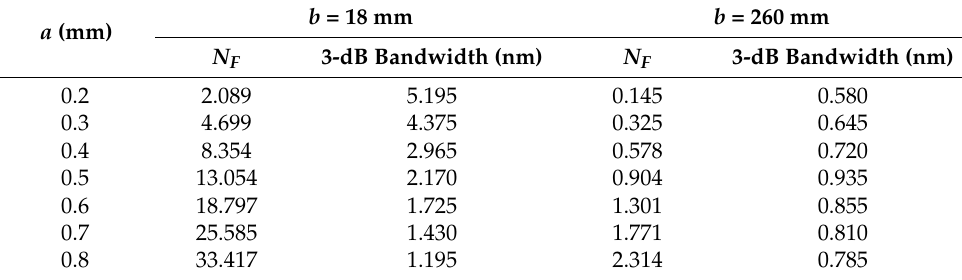
Figure 5. Bandwidth variation as function of the slit widths for b values of 18 mm and 260 mm and as function of the gratings length, L (for λ = 1532 nm and n eff = 1.445). Table 1. N F and 3 dB bandwidth values of the produced USFBGs.